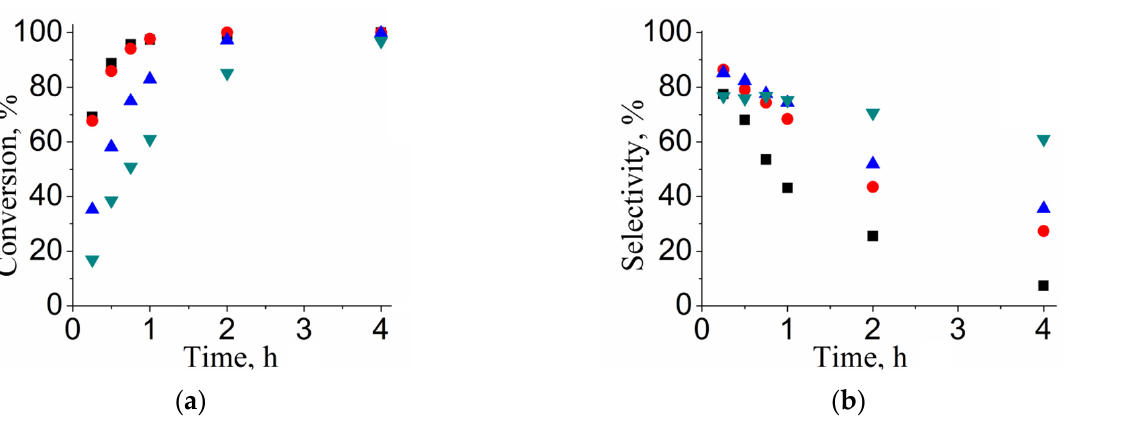
Figure 6. The catalyst loading influence on the unsaturated FAME conversion ( a ) and epoxides se- lectivity ( b ). Reaction conditions: FAME content of 1 wt%; unsaturated FAME:H 2 O 2 molar ratio of 1:8; temperature of 60 °C; and catalyst loading of 30 g·L − 1 ( ), 15 g·L − 1 ( ), 7.5 g·L − 1 ( ) and 3.75 g·L − 1 ( ).